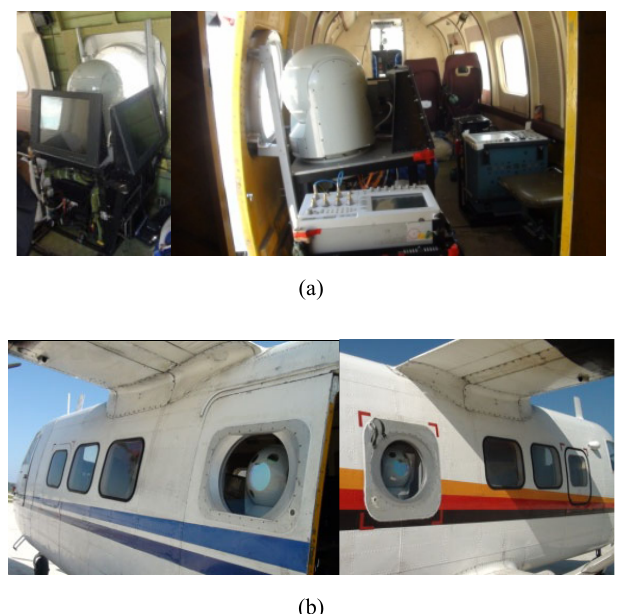
Fig. 3 Experimental setup: (a) installation of the airborne PAT system inside the cabin and (b) optical window for the laser communication test onboard two fixed-wing aircrafts.